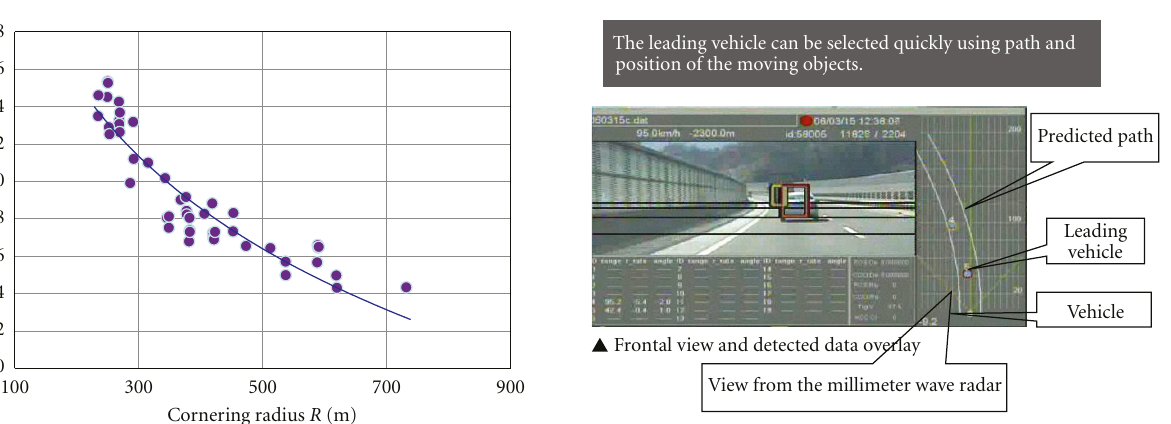
Figure 11: Relationship between amount of correction dβ and cornering radius R (vehicle velocity: 70–75 km/h).